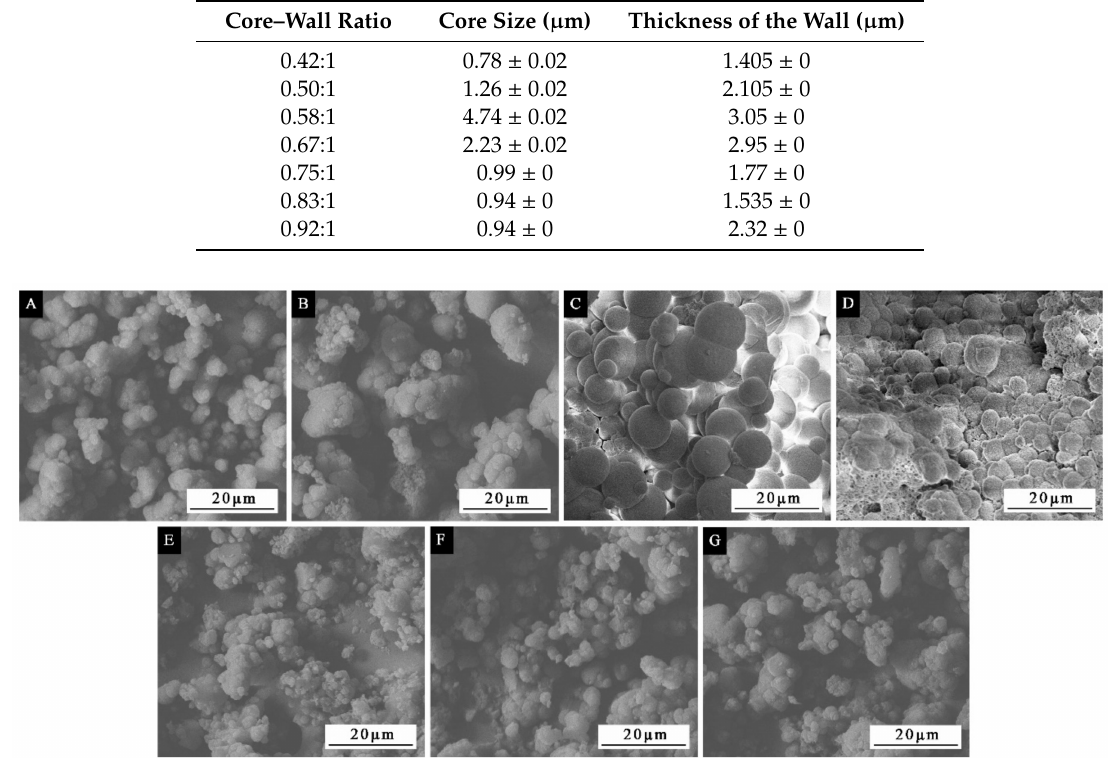
Figure 2. SEM of microcapsules. ( A ) 0.42:1; ( B ) 0.50:1; ( C ) 0.58:1; ( D ) 0.67:1; ( E ) 0.75:1; ( F ) 0.83:1; ( G )